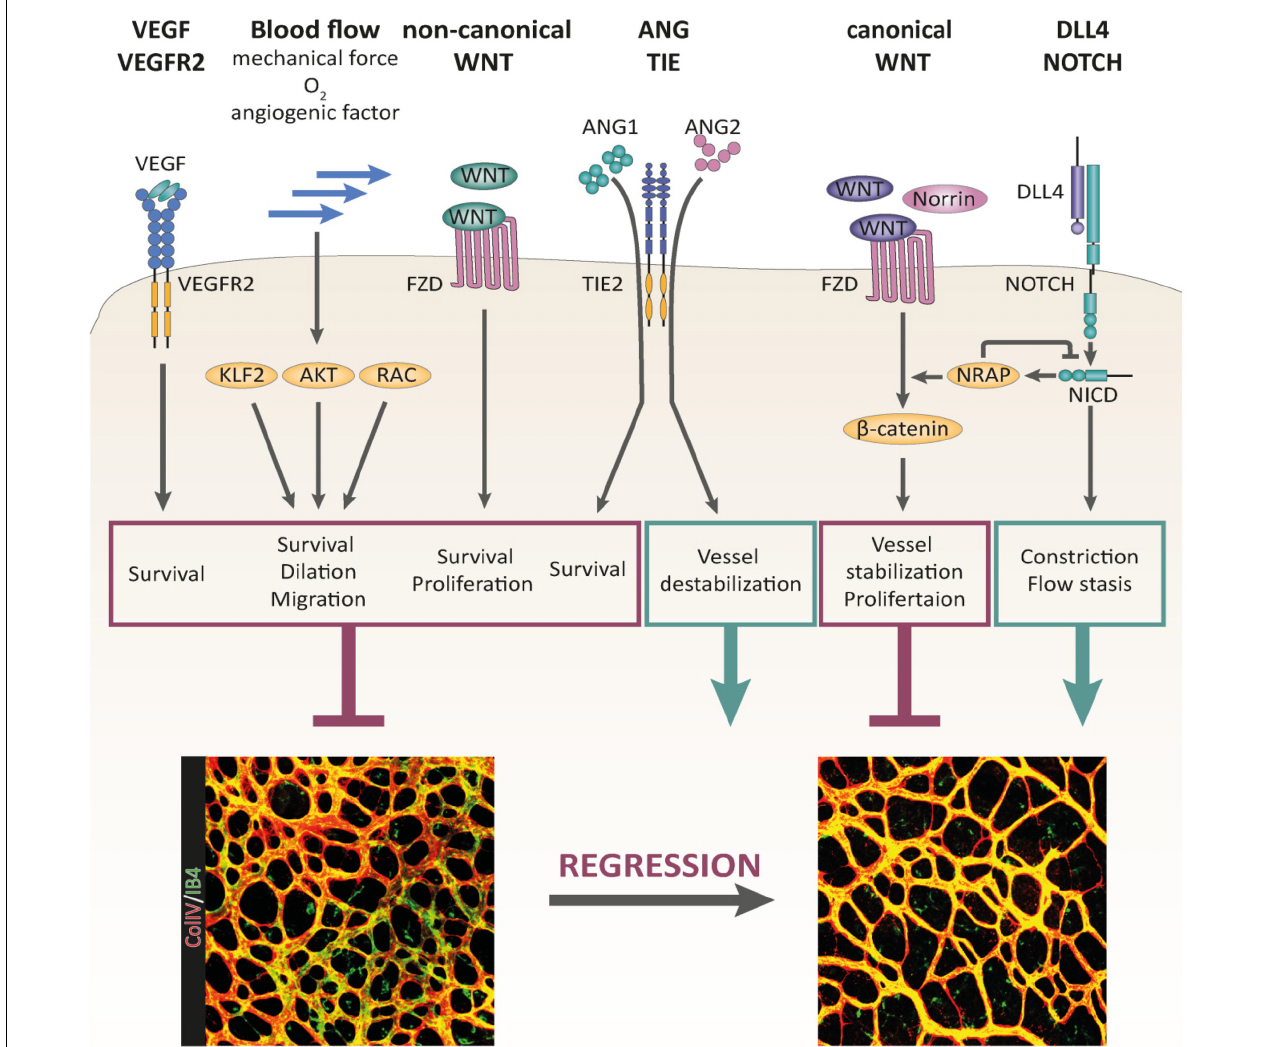
FIGURE 2 | Signaling pathways controlling BV pruning and regression, reproduced from Korn and Augustin (2015), Korn and Augustin (2015). Multiple signaling pathways have been identified as regulators of BV regression. VEGF/VEGFR-2 signaling, non-canonical WNT signaling, and blood flow-induced signaling serve as critical maintenance factors of the vasculature that are involved in the control of BV regression. Canonical WNT signaling stabilizes the vascular network and promotes EC proliferation. DLL4/Notch signaling supports BV regression by promoting BV constriction and flow stasis. The outcome of ANG/TIE signaling during BV remodeling is context dependent. Whereas ANG1 supports EC survival, ANG2 destabilizes the vascular network, driving it into regression in the absence of survival factor activity (e.g.,